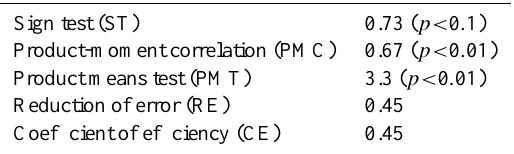
Table 1. Verification statistics according to the linear transfer model of δ 18 O and relative humidity within the calibration period AD1956–1996.